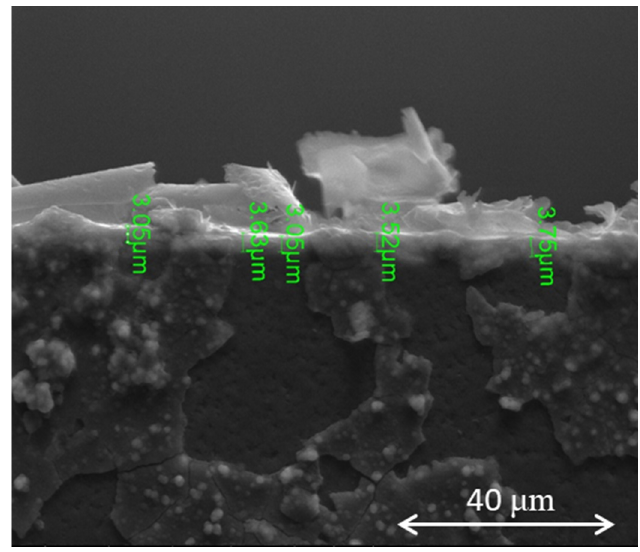
Figure 6. SEM of the Ni-MOF-74 thin membrane as a cross section. Thickness of the membrane highlighted by green text.